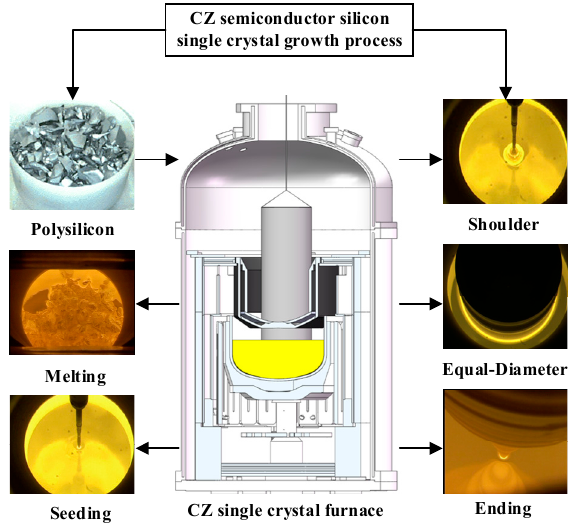
Figure 1. Schematic diagram of the CZ silicon single crystal growth process.